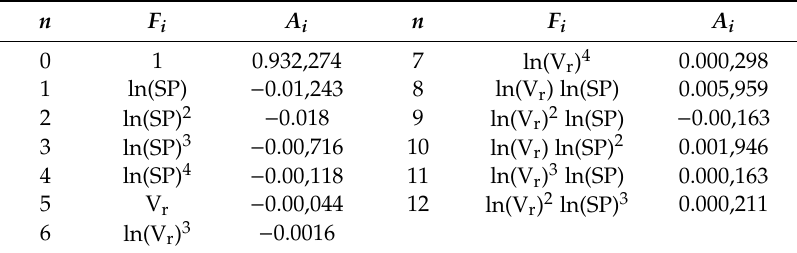
Table 2. Coe ffi cients used in the turbine e ffi ciency calculation correlation [19].